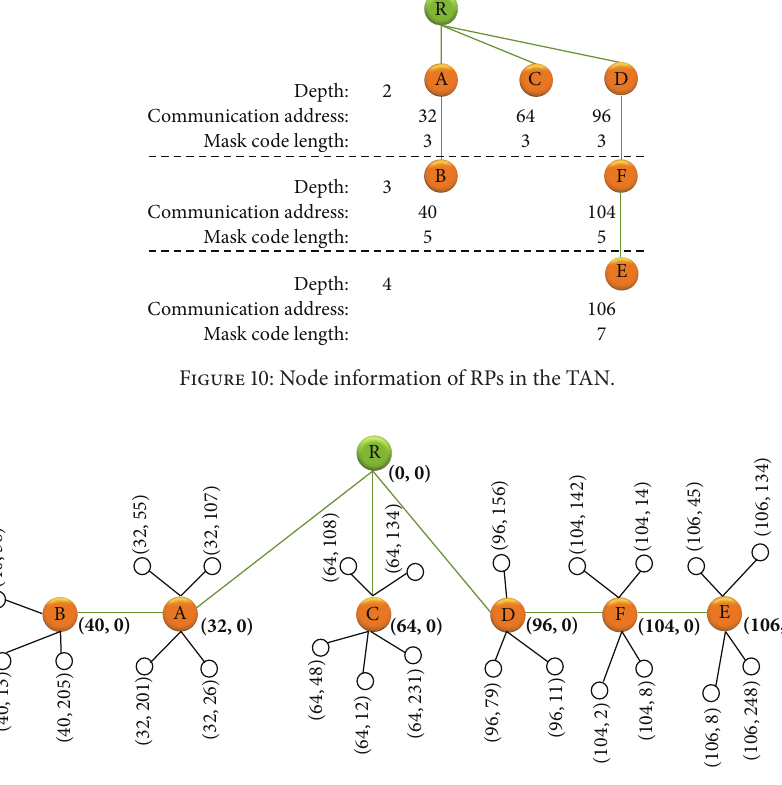
Figure 11: Optimal topology and node address of the IHM-WSN in the field